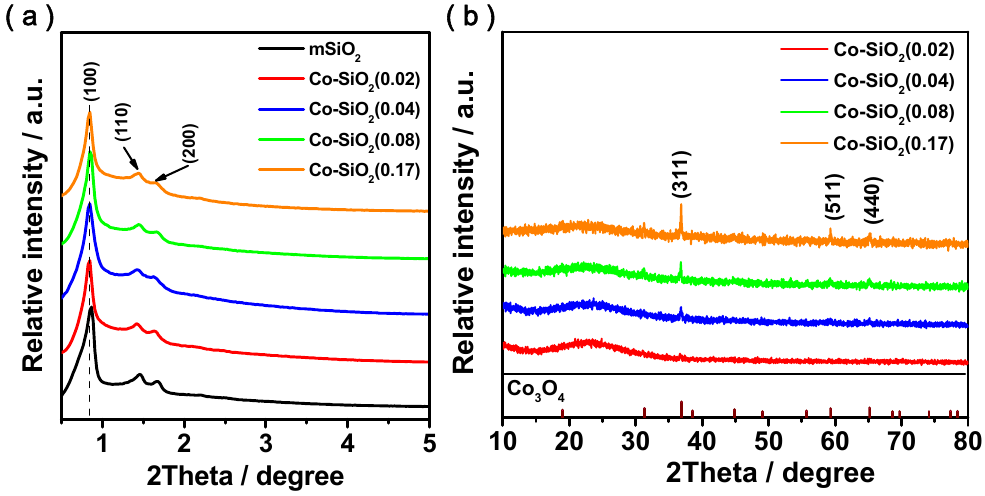
Figure 2. Low ( a ) and wide ( b ) angle XRD patterns of the mesoporous Co–SiO 2 ( x )